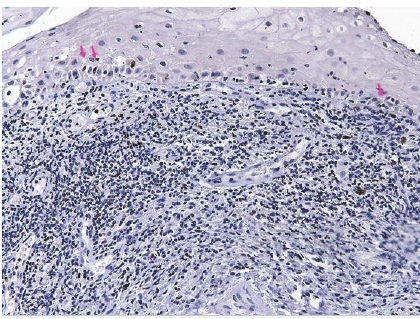
Figure 3: (A) Increased immunoreactivity of the p53 protein from the adjacent region towards the tumor region (less magnification); (B) transition area. Arrows indicate marking of nuclei to p53 in a region adjacent to the tumor; asterisk marks tumor region (highest magnification).